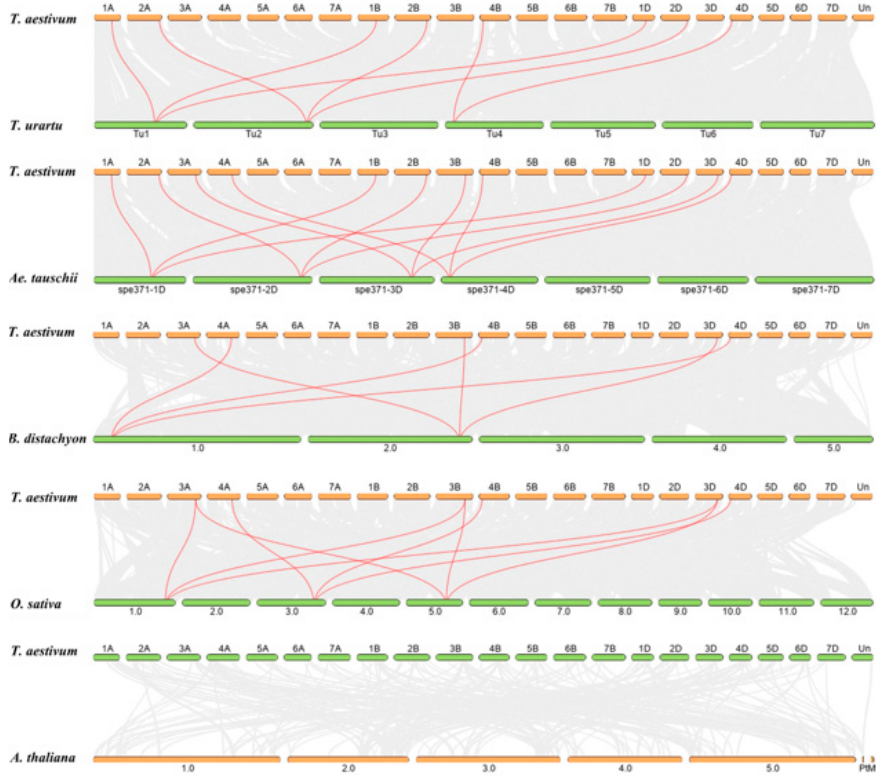
Figure 3. Syntenic relationships between TaSHMT genes in T. aestivum with other SHMT genes in Figure 2. Chromosomal localizations and syntenic relationships among TaSHMT genes in wheat. five other representative plant species. Gray lines in the background indicate the collinear blocks Red lines indicate the syntenic TaSHMT gene pairs. within T. aestivum and other plant genomes. Red lines indicate the syntenic SHMT gene